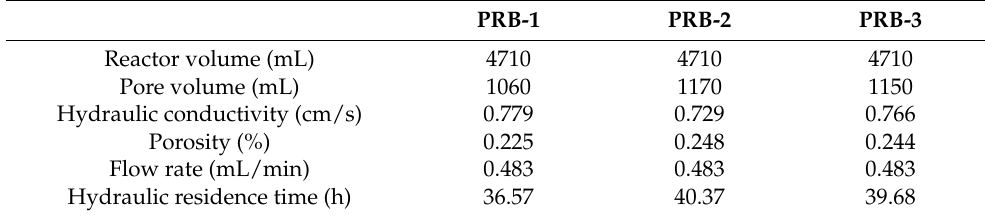
Table 5. Hydraulic parameters for PRBs.